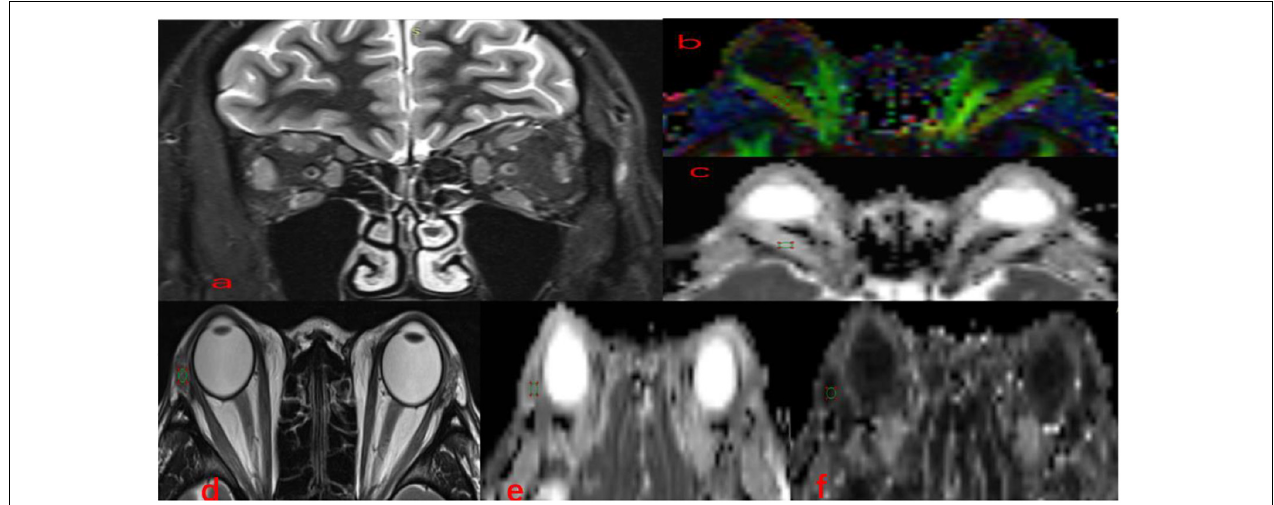
FIGURE 1 | Methods for DTI parameters measurements in EOMs and LG. Coronal (a) fat-suppressed T2-weighted images and color-coded FA (b) , MD (c) , in a 36-year-old man with TAO. A circular region of interest was manually set on each EOM locating the clearest cross-section. Axial (d) T2-weighted images, FA (e) , MD (f) maps of the same patient. A circular region of interest was manually set on each LG indicating the clearest cross-section. TAO, thyroid-associated ophthalmopathy; EOMs, extraocular muscle; DTI, diffusion tensor imaging; LG, lacrimal gland; FA, fractional anisotropy; MD, mean diffusivity.